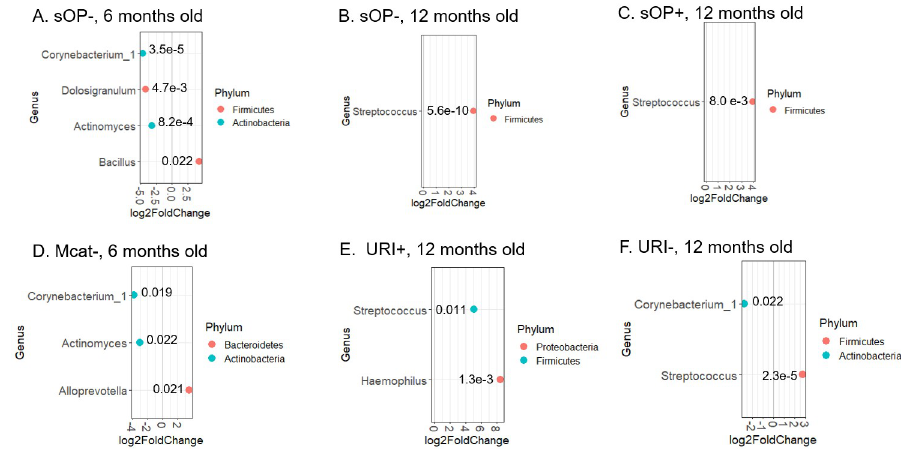
Fig 4. Mcat detection, URI and Otitis Proneness as factors that contribute to microbiome difference between Spn+ and Spn- NP samples. Samples were divided into AOM-free/sOP, Mcat+/Mcat-, and URI+/URI- samples at each age group. Differential abundance of genera between Spn+ and Spn- samples was determined in each subgroup: AOM-free/sOP (A-C), Mcat (D), or URI (E-F), by DESeq2 software (see Materials and methods). The ones with adjusted p value less than 0.05 are shown as dots in the graphs. The adjusted p value is indicated next to each dot. The x axis exhibits the log 2 ratio between abundance of bacterial genera in Spn+ samples and that in Spn-